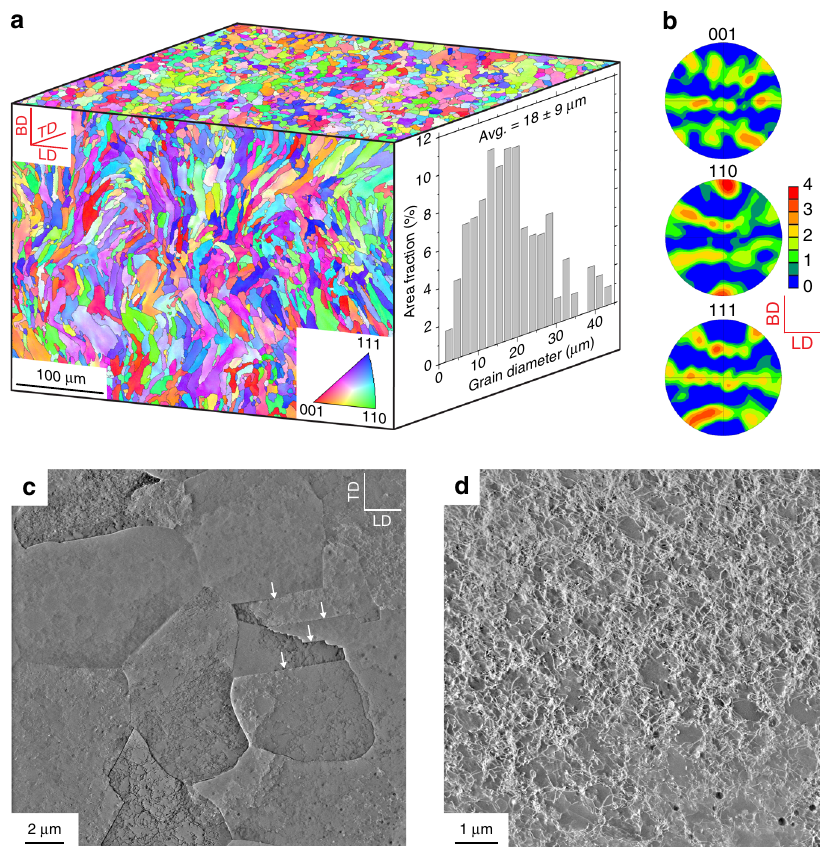
Fig. 1 Microstructure of as-printed 316L stainless steel. a EBSD image along the build direction (BD) and transverse direction (TD), respectively. The EBSD image along the loading direction (LD) is similar to that along TD. The grain size distribution is obtained from the top surface (the TD-LD plane) in the image. b The 001, 110, 111 pole fi gures corresponding to the EBSD image taken along BD. c Top-view HAADF STEM image of the same sample in a . Tangled dislocations and a few twin boundaries (marked with white arrows) are visible; cellular structures are poorly de fi ned. d A higher resolution HAADF STEM image of cellular structures compared to c . Some precipitates are visible